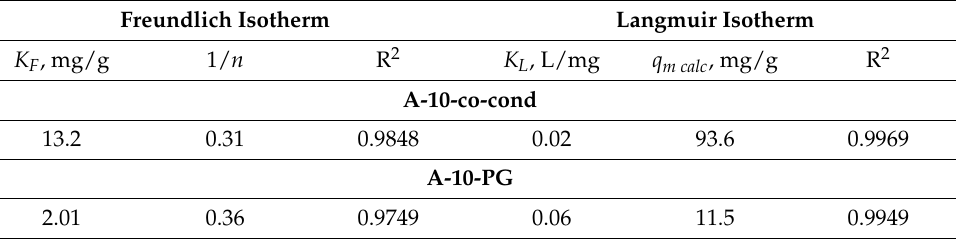
Table 4. Parameters of the isotherm models for adsorption of Cr(VI) on the adsorbent